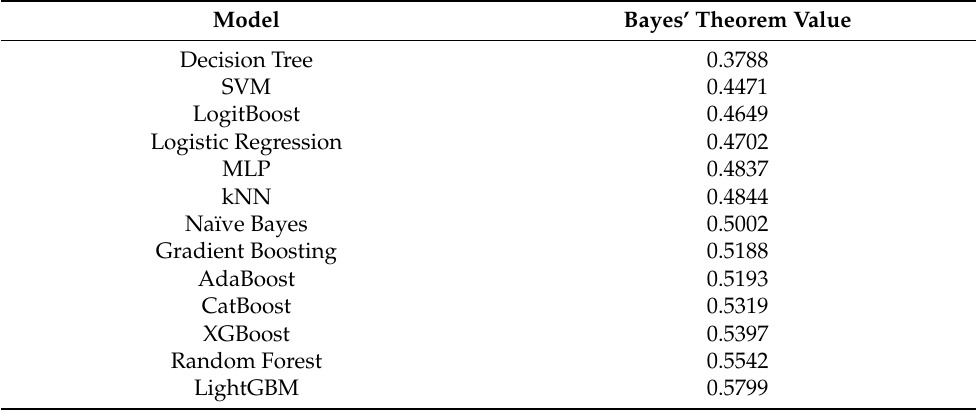
Table 10. Bayes’ Theorem values in ascending order for the 13 ML